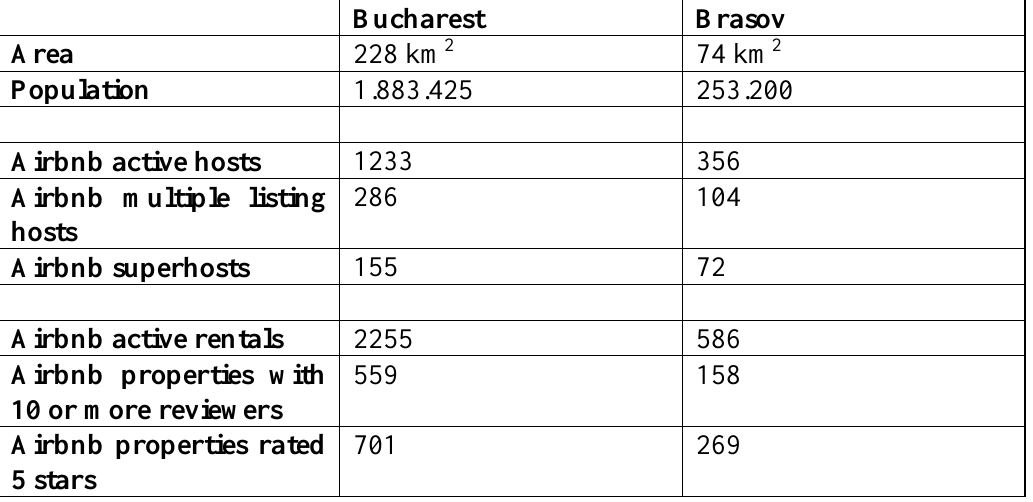
Figure 6: Airbnb hosts and rentals, June 2017